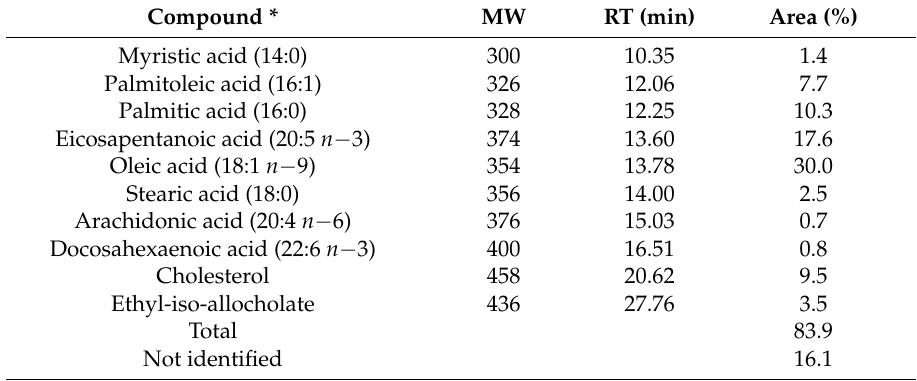
Table 1. Chemical properties of extracted bullfrog oil. Composition ( A ) and oxidation induction time ( B